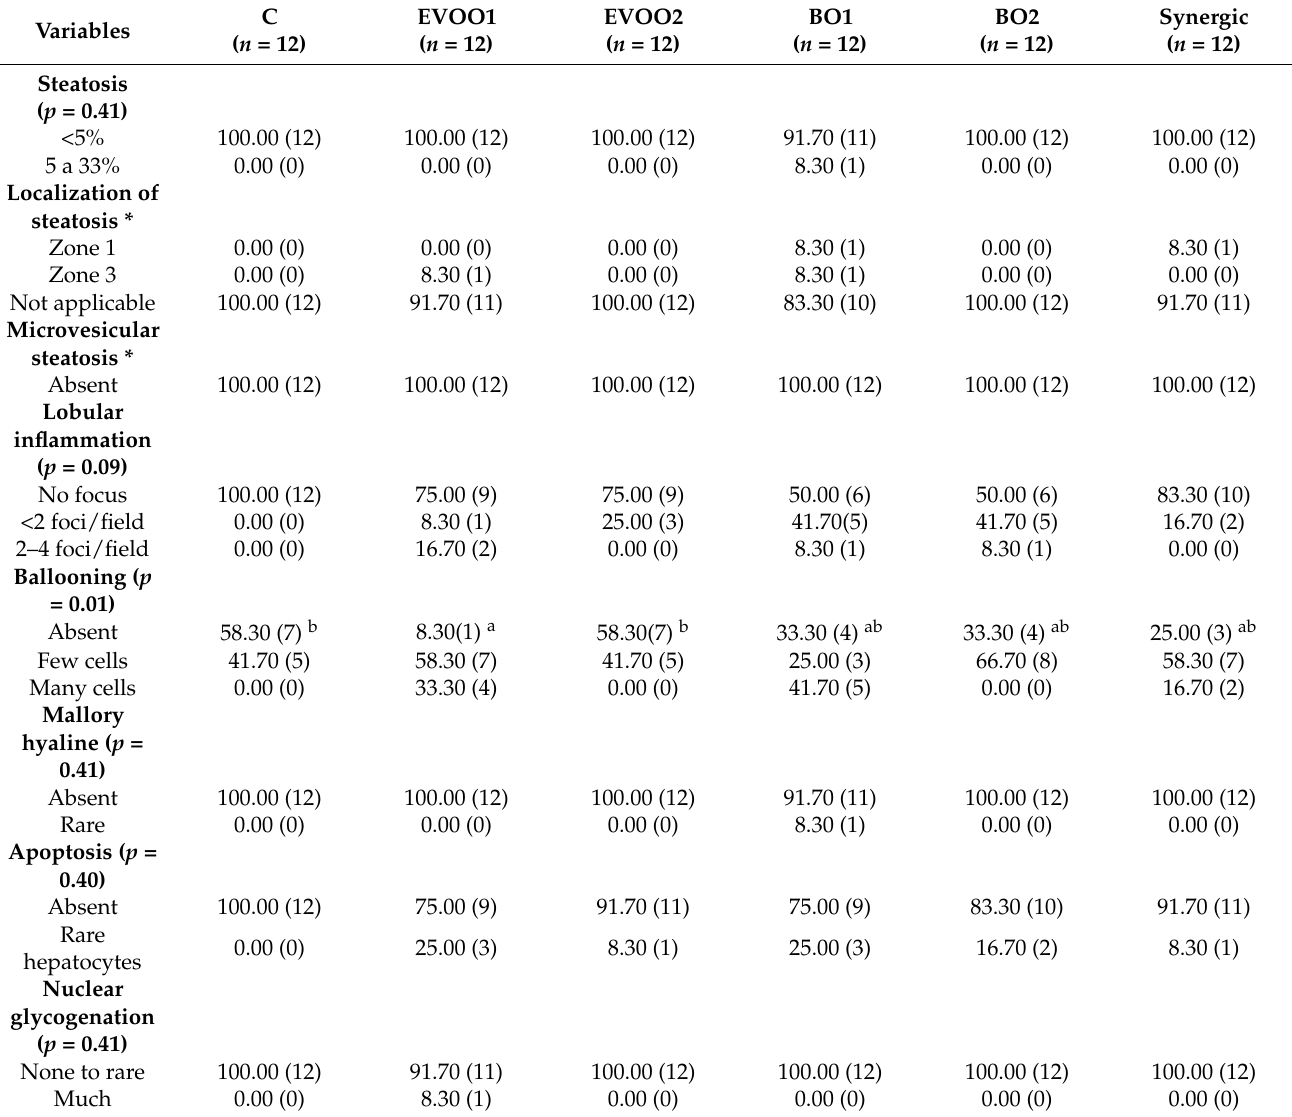
Table 9. Histopathological analyses of the liver with scores for hepatic steatosis, localization of steatosis, macrovesicular steatosis, lobular inflammation, ballooning, Mallory hyaline, apoptosis, and nuclear glycogenation of the animals after 90 days of